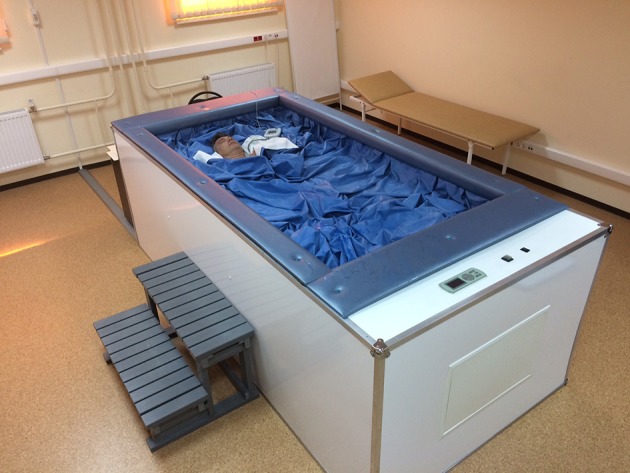
The condition of dry immersion. © PetrSU/L. Gerasimova-Meigal.